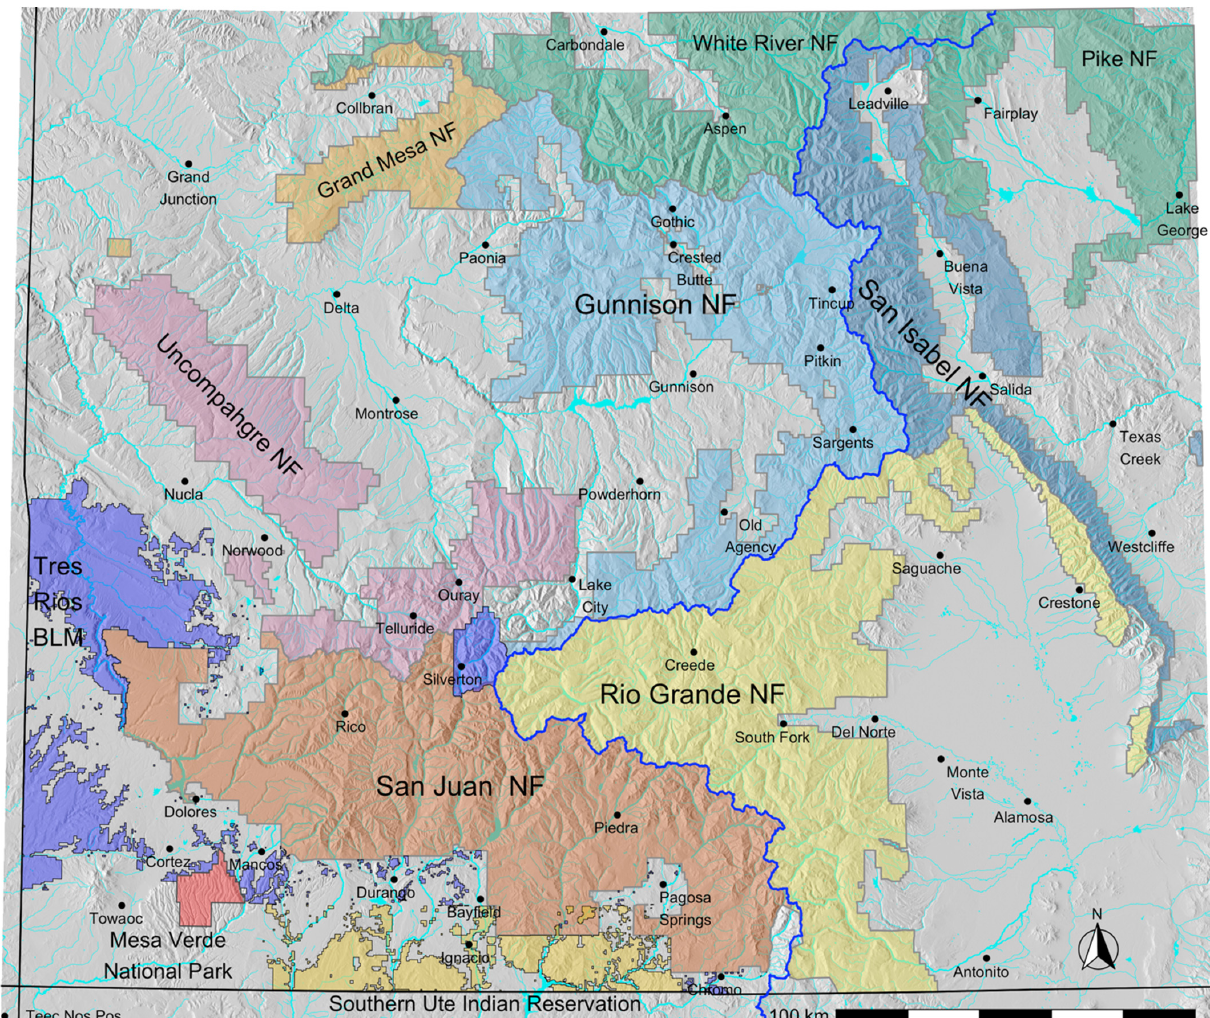
Figure A1. Modeled area in southwestern Colorado, showing the land management units whose spatial vegetation data were sampled for the study. Blue line is the Continental Divide.